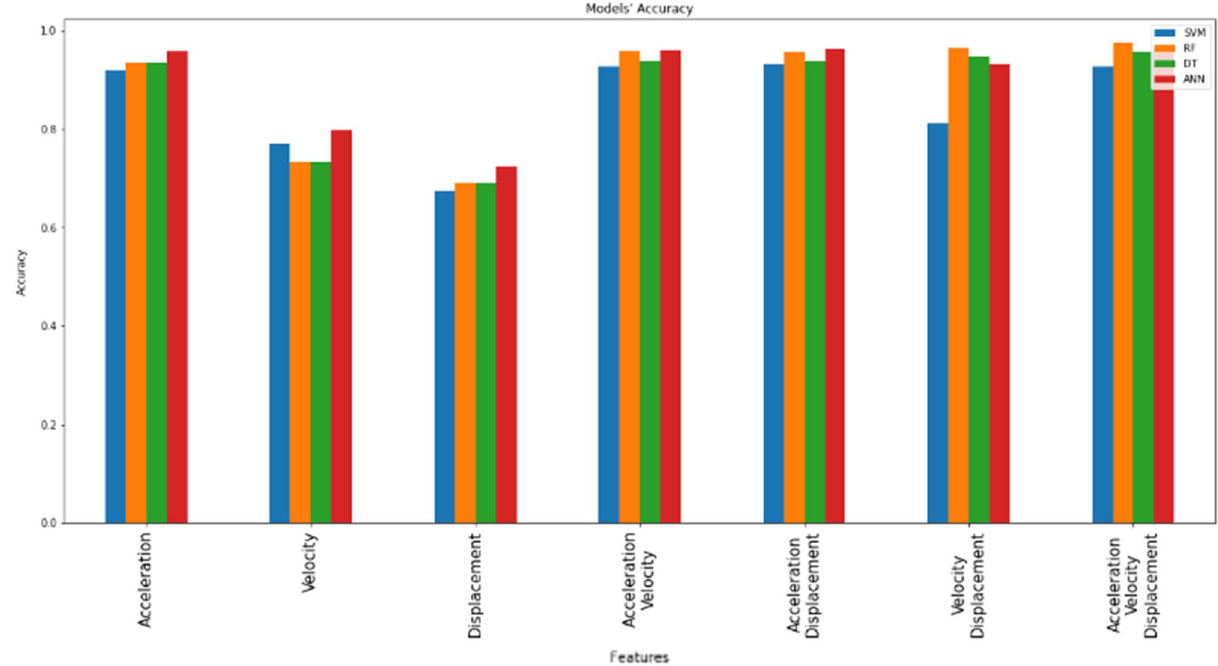
Figure 8. Models’ accuracy